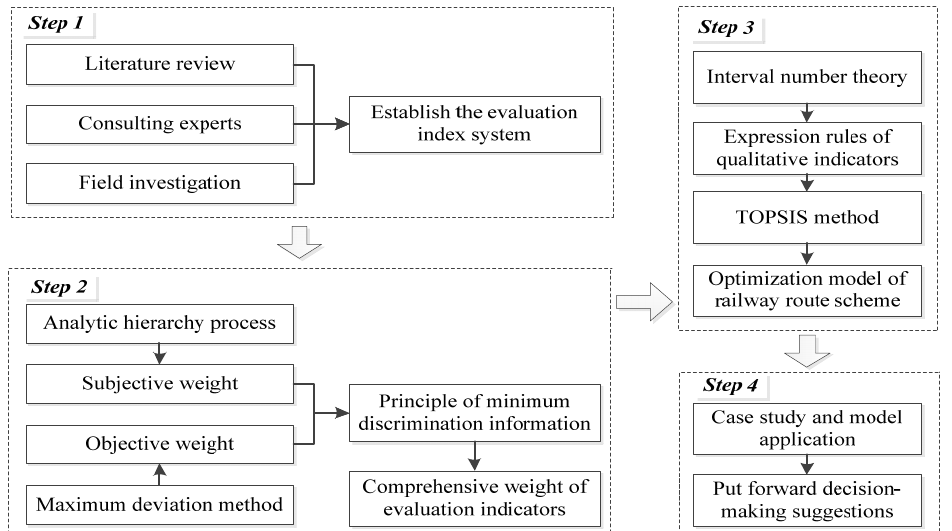
Figure 1. The research framework.